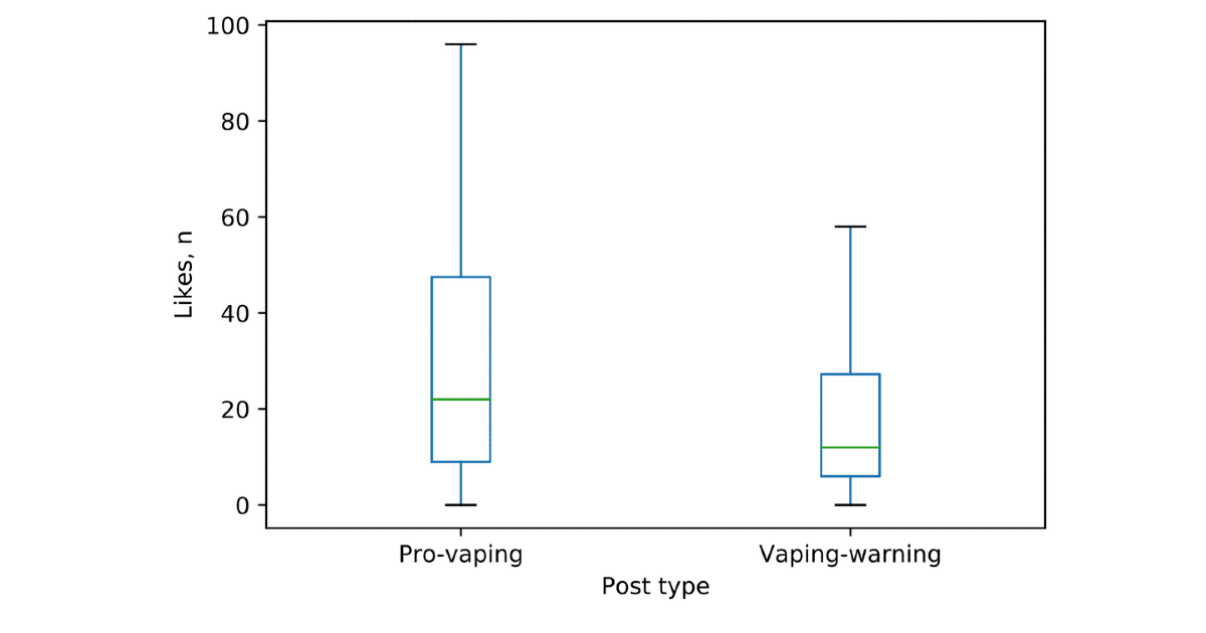
Figure 1. Number of "likes" for pro-vaping and vaping-warning posts.